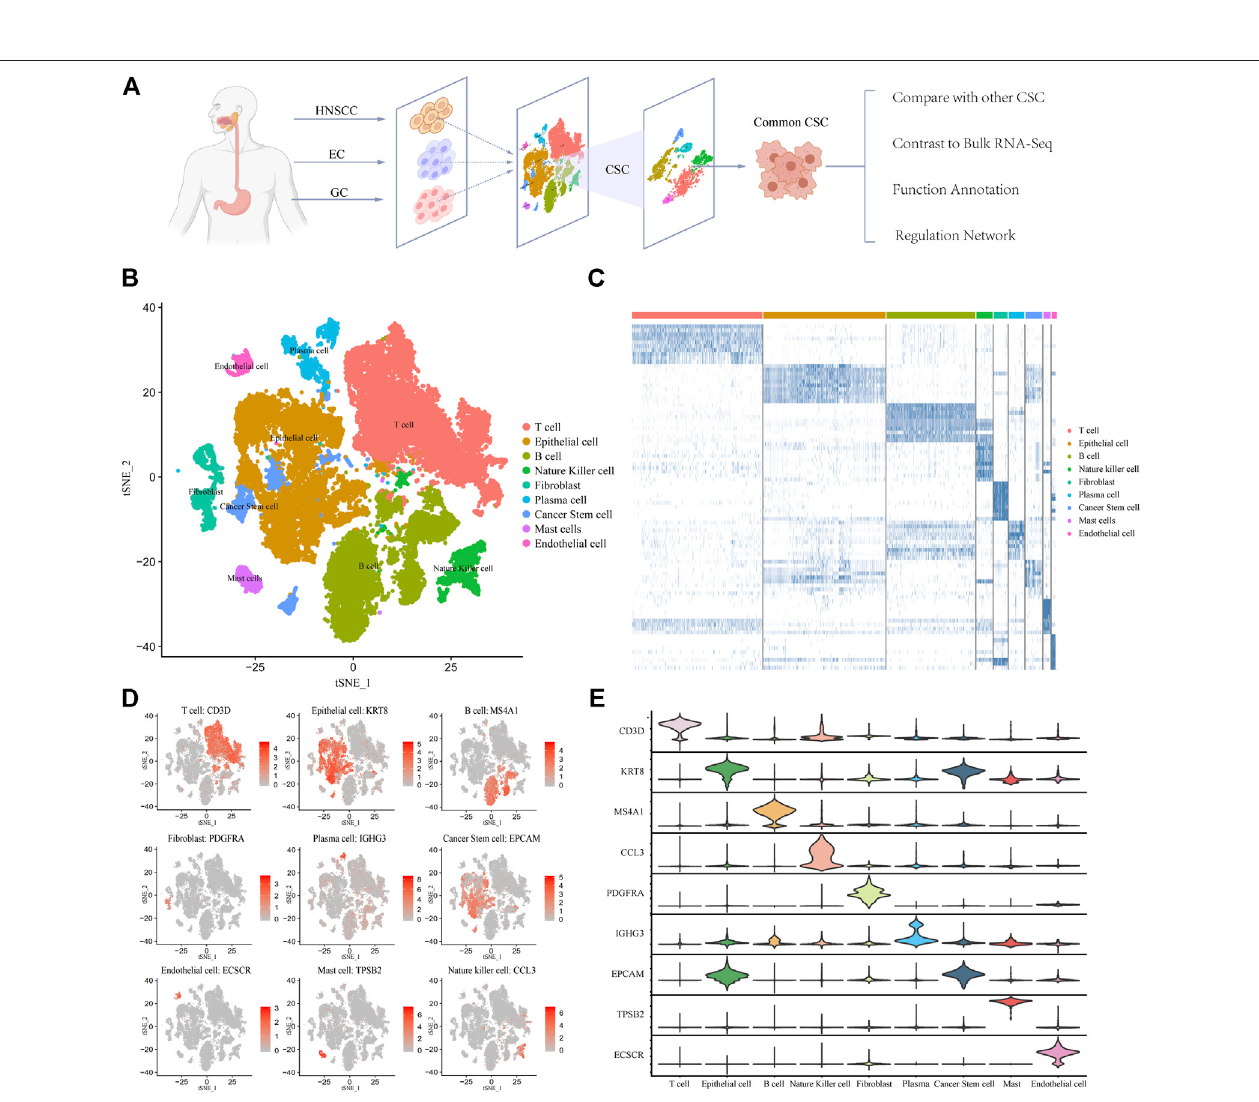
FIGURE 1 | Expression pro fi ling of 39,057 single cells in UGIC. (A) Work fl ow of sample processing, cell type annotation, and functional analysis for 30 samples in UGIC. (B) t-SNE of 39,057 cells pro fi led here, with each cell color-coded for the associated cell type. (C) Heatmap of the expression pattern in each cell type. (D) Expression of marker genes for the cell types de fi ned above each panel. (E) Expression trend of marker genes for each cell type in the violin chart.